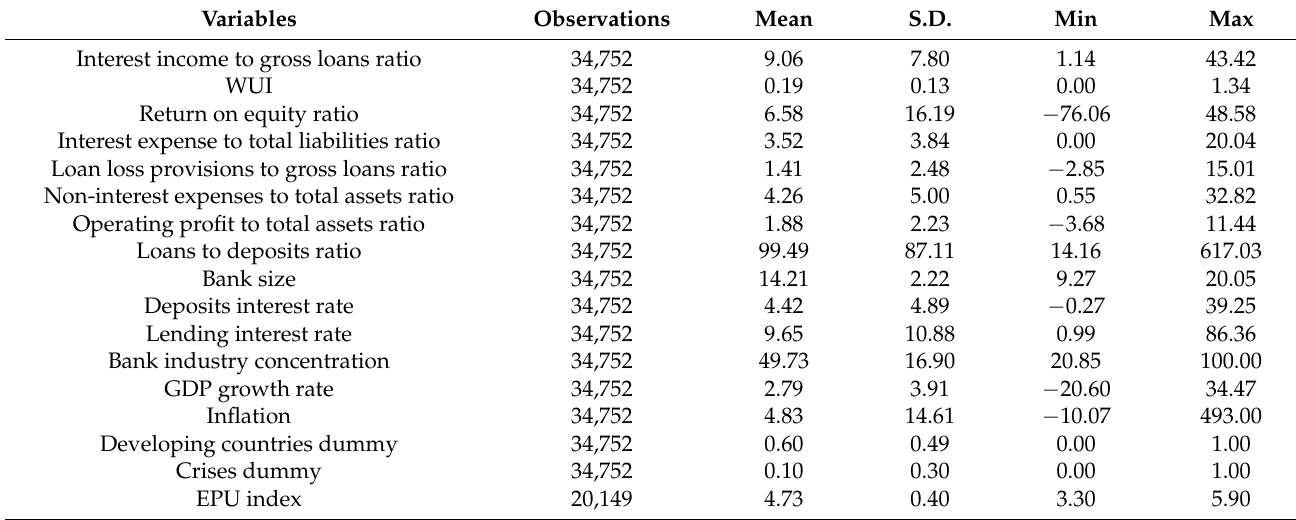
Table 3. Summary statistics of main